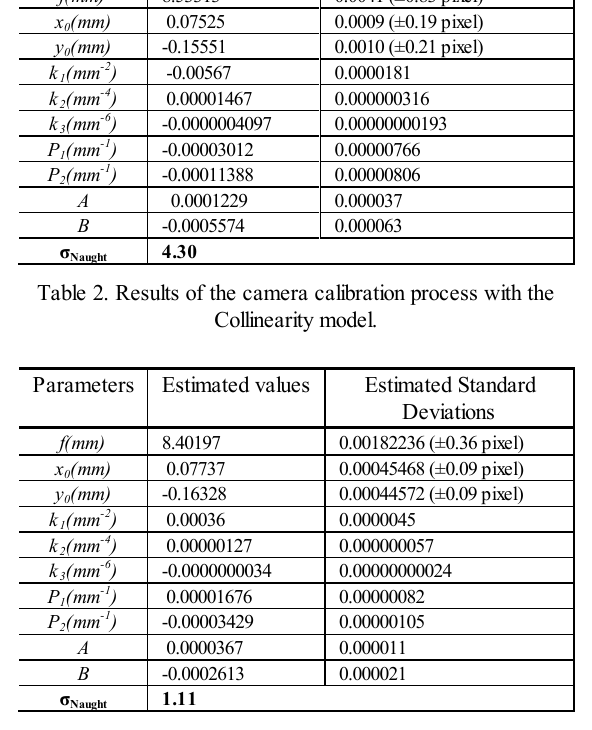
Table 3. Results of the camera calibration process with the equidistant model.